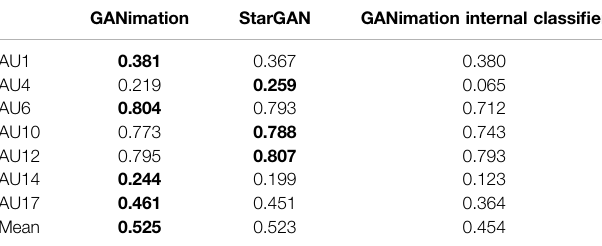
The best results are shown in